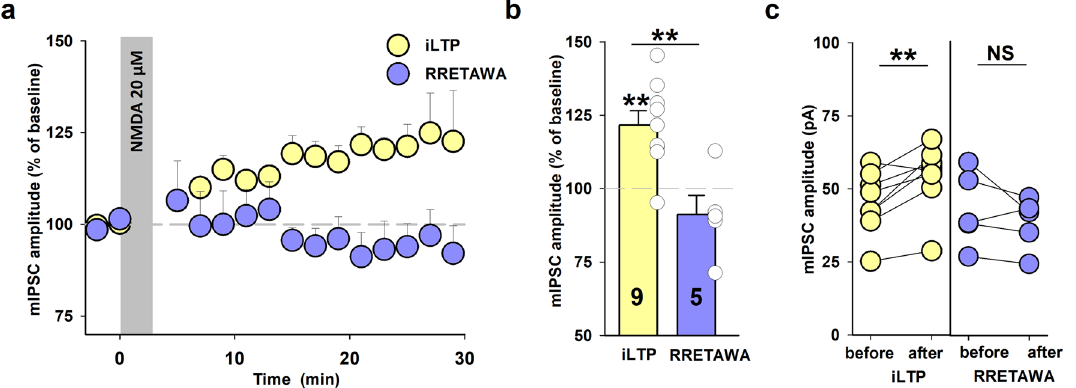
Figure 6. Administration of α5β1 integrin occludes NMDAR-dependent iLTP in SST + INs. ( a ) Time course of mIPSC amplitude after iLTP induction with NMDA (gray bar), recorded from control slices (yellow) and in the presence of RRETAWA peptide (0.15 mM, purple). ( b ) Statistics for iLTP magnitude 16–18 min. after the end of NMDA application in control conditions (yellow bar) and RRETAWA-treated slices (purple bar, asterisk for t -test comparison between the two groups). Note that the induction of NMDAR-dependent iLTP in the presence of RRETAWA was abolished. Asterisks above bin show increase in mIPSC amplitude (relative to baseline). ( c ) Absolute value of mean mIPSC amplitudes in individual recordings before and 16–18 min. after iLTP induction in control and RRETAWA-treated group (paired t -test). Every significant difference is marked by ** p < 0.01; NS, non-significant.